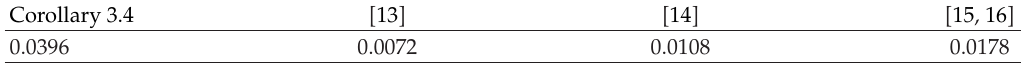
Table 1: A comparison of the upper bound of impulsive intervals of (cid:3) 4.1 (cid:4) . Corollary